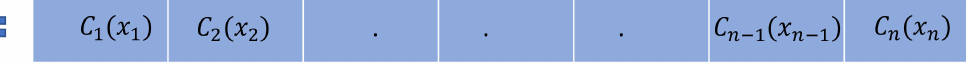
Figure 10. EA Chromosome configuration for the SGB field configuration cases. Then, the population Matrix C will be constituted by the aggregation of all C l individ- uals with dimensions N ind x n